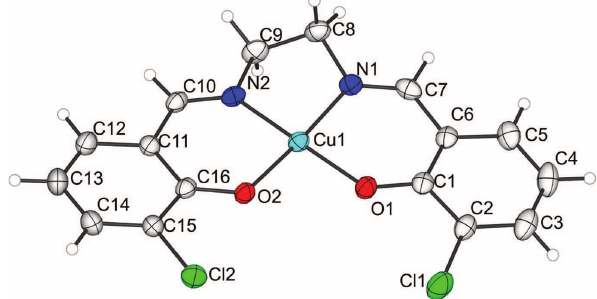
Table 1: Data collection and